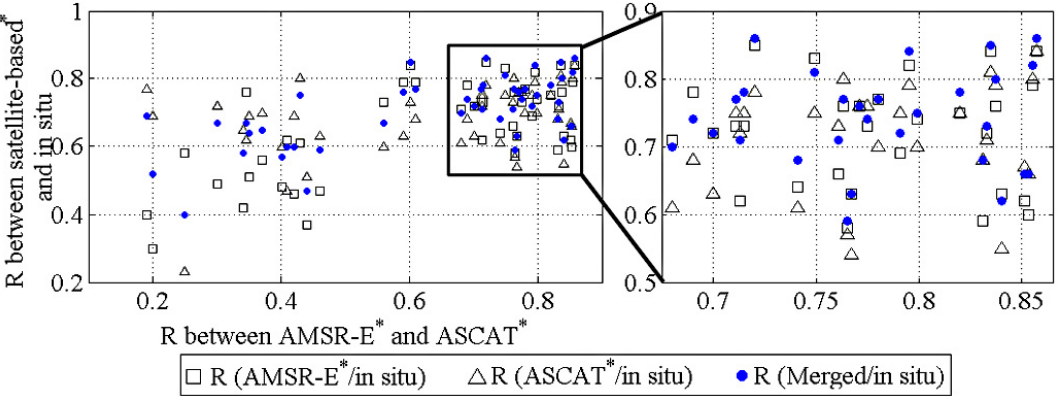
Fig. 8. Relationships between correlation coefficients (R) between AMSR-E* (square), ASCAT* (triangle), and AMSR-E*/ASCAT* (i.e., merged product) (blue closed circles) with in situ observations, respectively.